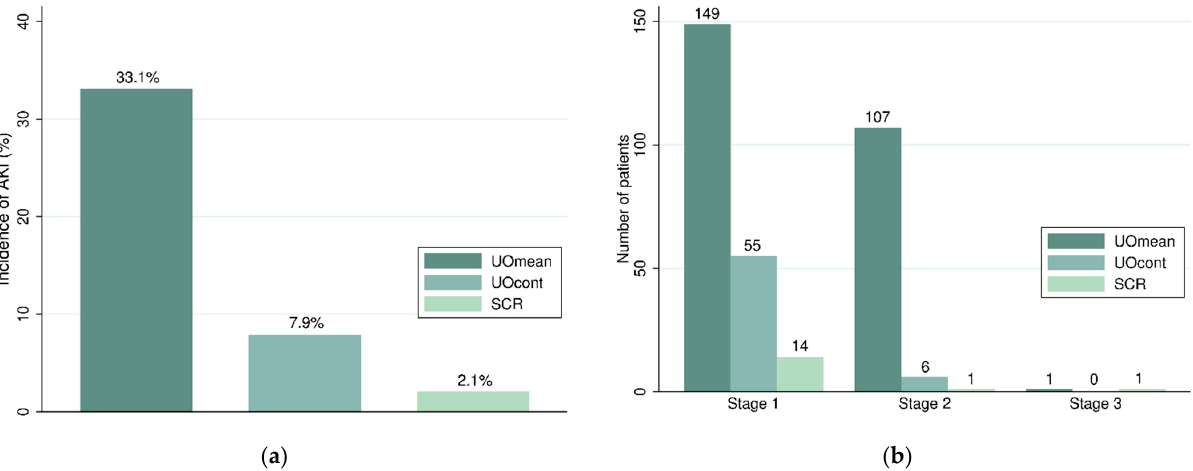
Figure 2. ( a ) Incidence of AKI identified by different criteria within 48 h of admission to the ICU after non-cardiac surgery. ( b ) Incidence of each stage of AKI. UOmean is mean urine output <0.5 mL/kg/h or <0.3 mL/kg/h within a sliding window of 6, 12, or 24 h. UOcont is urine output <0.5 mL/kg/h or <0.3 mL/kg/h hourly within a sliding window of 6, 12, or 24 h. SCR is serum creatinine increase of ≥ 0.3 mg/dL or 1.5–3 times the baseline within 48 h.